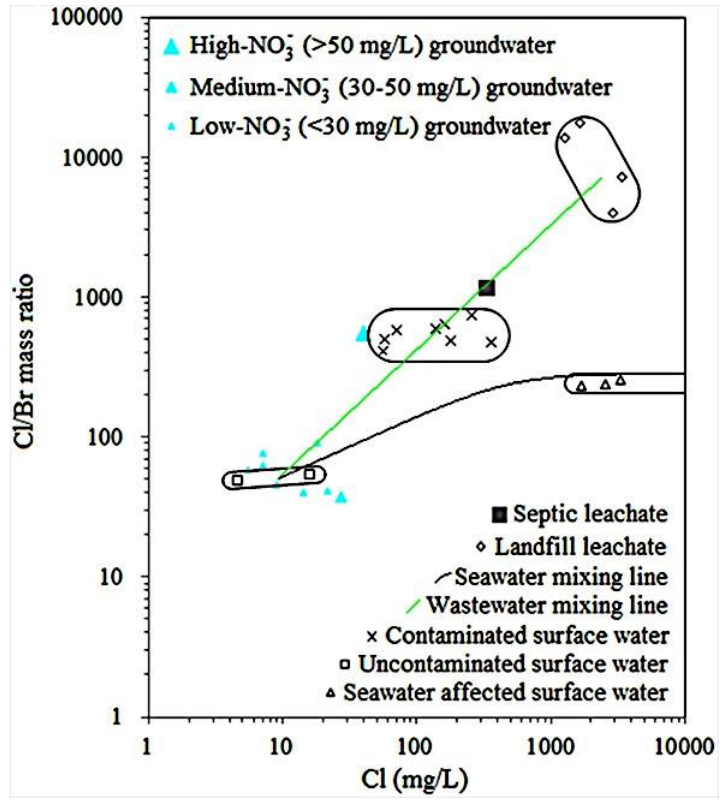
Figure 5. Plot of Cl/Br mass ratios versus Cl concentrations in karst aquifers.